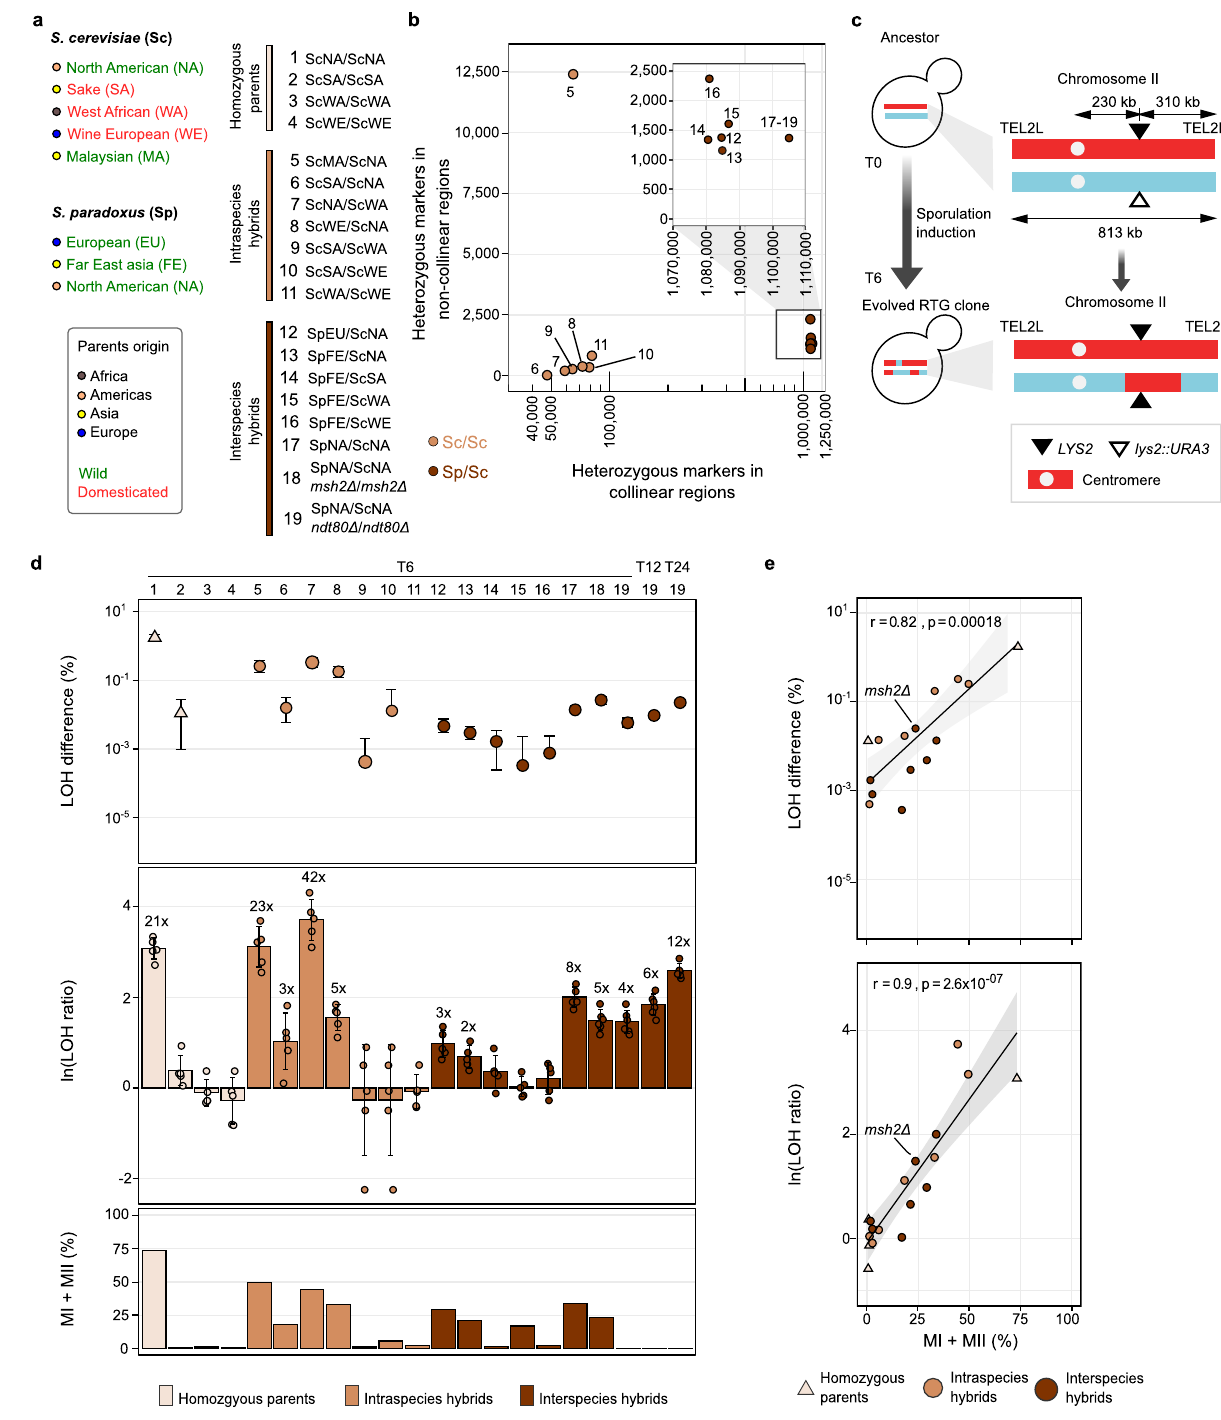
ScNA interspecies hybrid. Indeed, we observed increased LOH rates in both T0 (3.6-fold) and T6 (twofold) samples compared with the wild-type SpNA/ScNA hybrid (Supplementary Data Set 4), despite meiotic progression being slower in the msh2 Δ mutant (Fig. 2d and Supplementary Fig. 3b). This is consistent with the mismatch-repair machinery acting to prevent RTG recombination in hybrids with highly diverged subgenomes. Finally, we generated a SpNA/ScNA ndt80 Δ with both high heterozygosity and meiotic progression defects, and we measured LOH ratios and differences after 6 (T6), 12 (T12) and 24